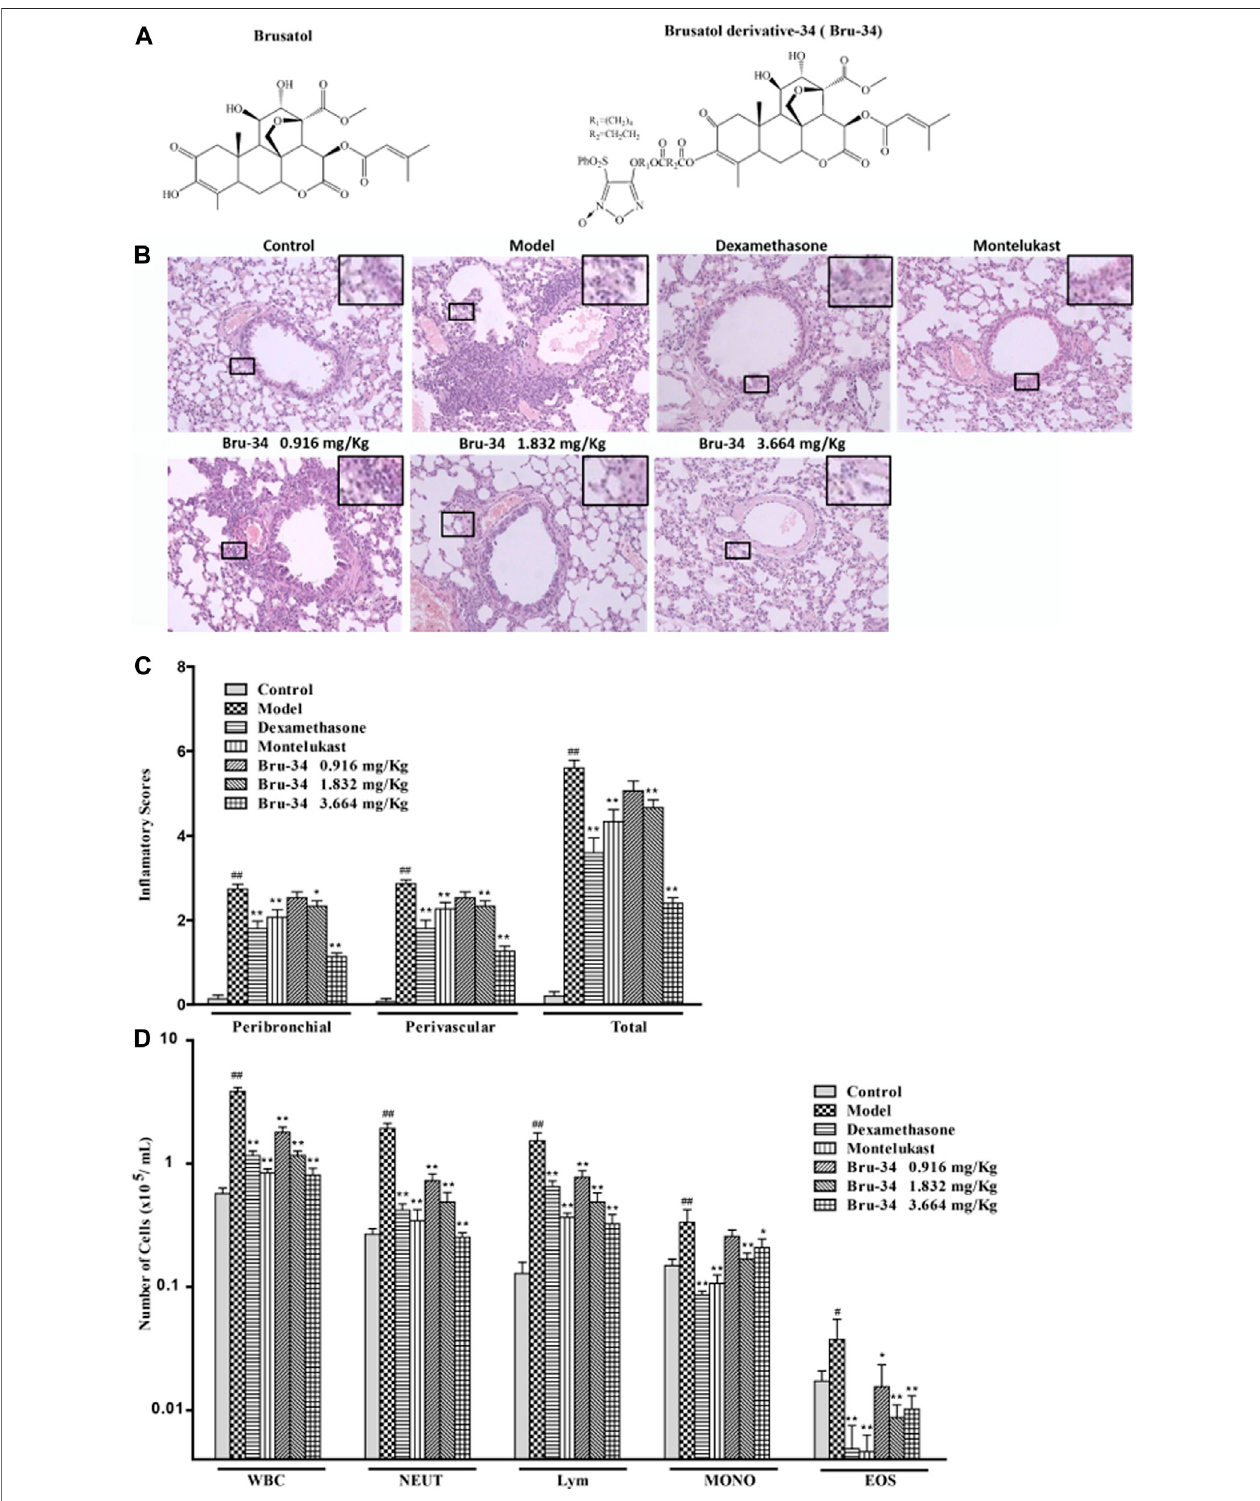
FIGURE 1 | Bru-34attenuated thein fl ammatorycellsin fi ltrationinOVA-dependentairwayin fl ammation.Panel (A) :ChemicalstructuresofbrusatolandBru-34;Panel (B) : Lung sections with hematoxylin-eosin (H&E) staining ( × 100); Panel (C) : A four-point in fl ammatory scores evaluated on the accumulation of in fl ammatory cells in H&E stainedlungsections( n (cid:2) 4);Panel (D) :Thenumberofin fl ammatorycellin fi ltratedinBALF( n (cid:2) 8);Datawereexpressedasmean ± S.D.;# p < 0.05and## p < 0.01vs.control group by Student ’ s t -test statistical analysis; * p < 0.05 and ** p < 0.01 vs. model group by one-way ANOVA statistical analysis, the same to the following fi gures.